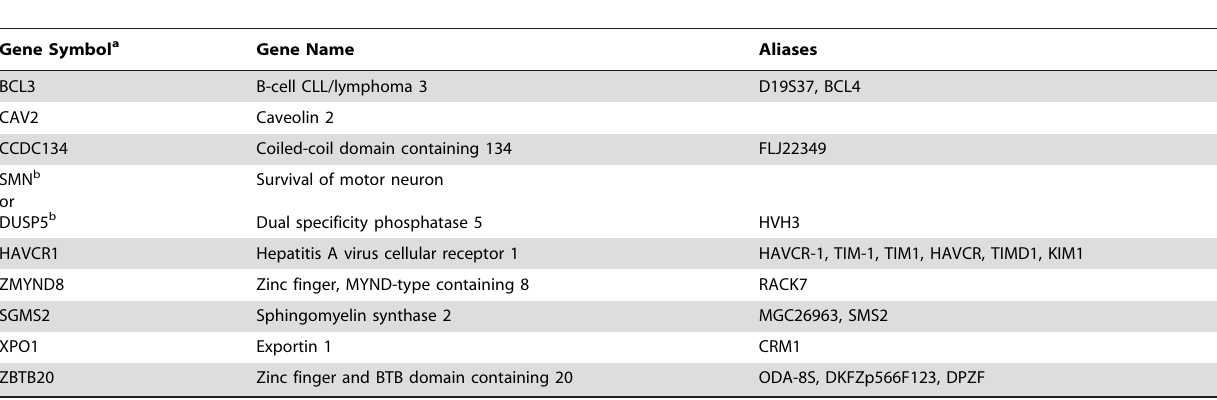
Table 1. Genes identified in e -toxin-resistant MDCK